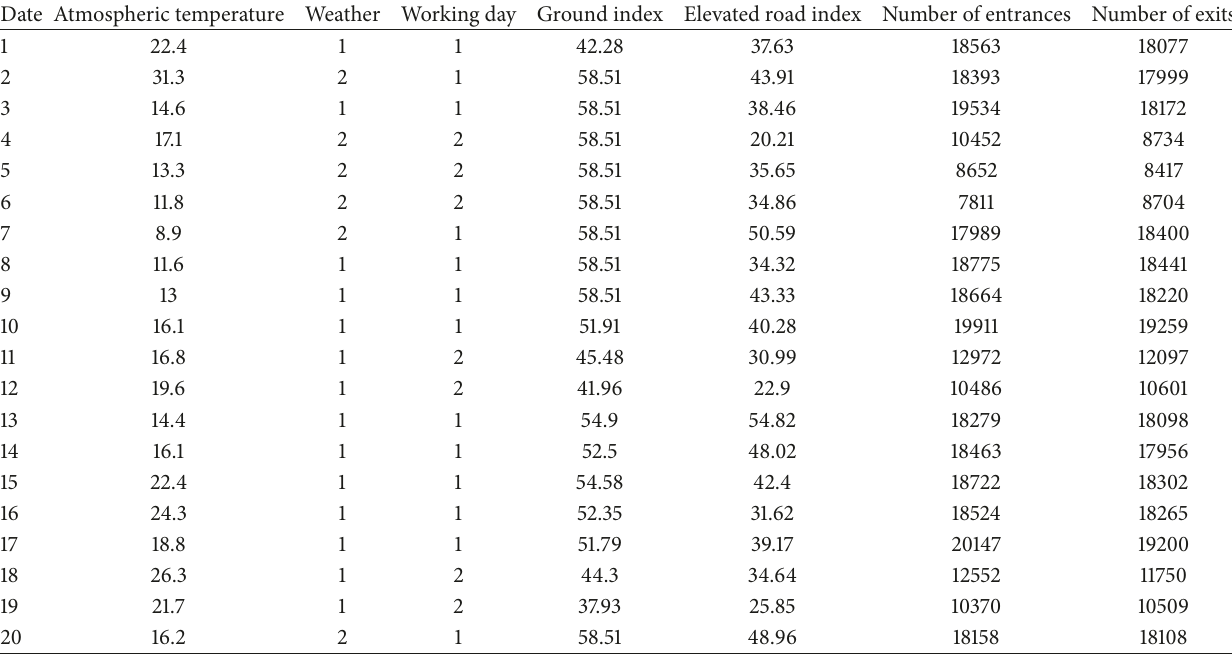
Table 5: Relevant data of passenger flow of Dabaishu rail transit